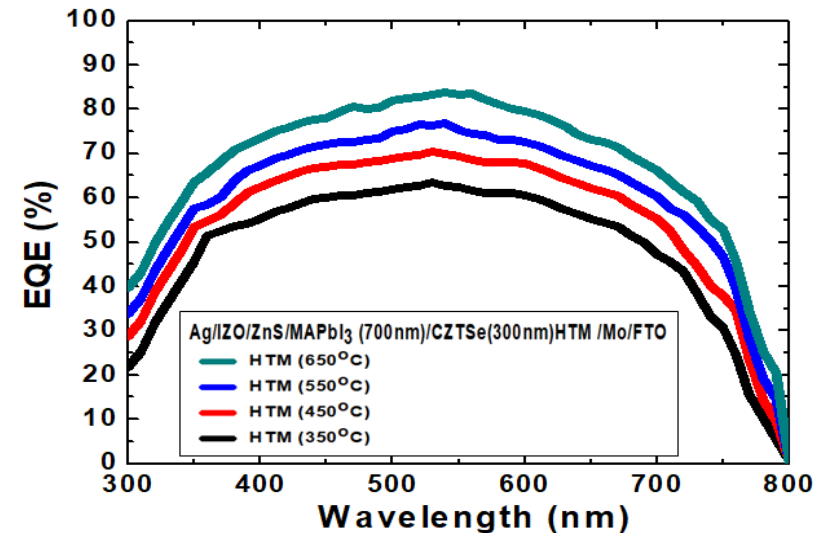
Figure 12. The EQE spectra based on Ag / IZO / ZnS / MAPbI 3 / Cu 2 ZnSnSe 4 / Mo / FTO nanostructured solar cells.